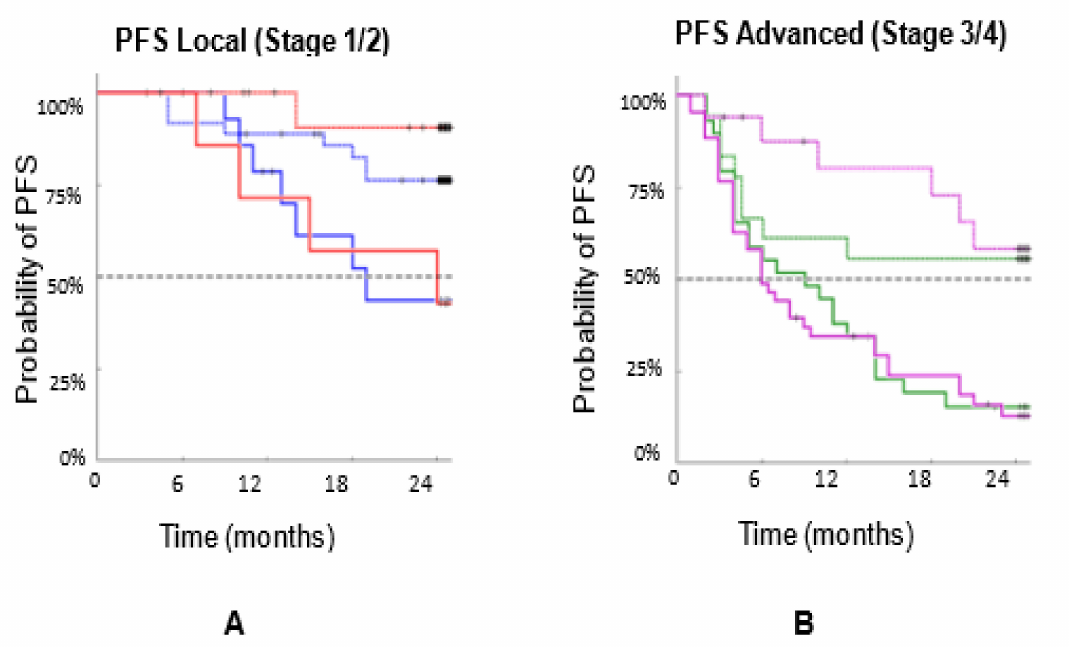
Figure 7. PFS of n = 192 patients with three types of cancers (breast, prostate, and lung) by stage. PFS based on CAML size, combining ( A ) Stages 1,2 (merging Figure 5A,B), and ( B ) Stages 3,4 (merging Figure 5C,D).